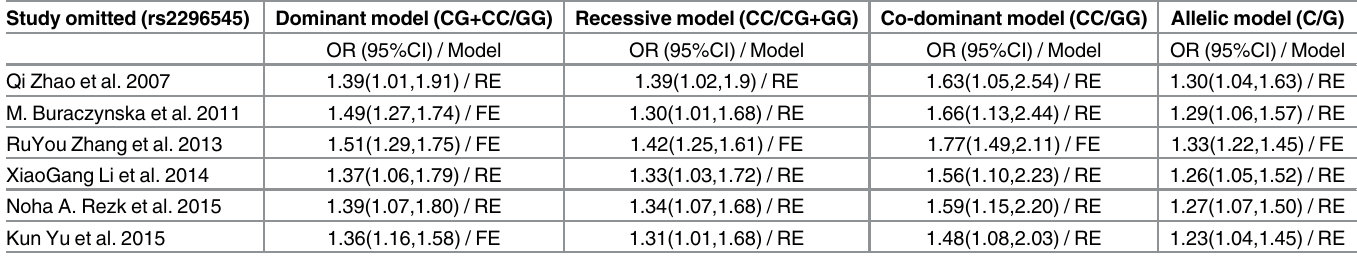
Table 3. Sensitivity analysis for association between rs2296545 and risk of hypertension. Study omitted